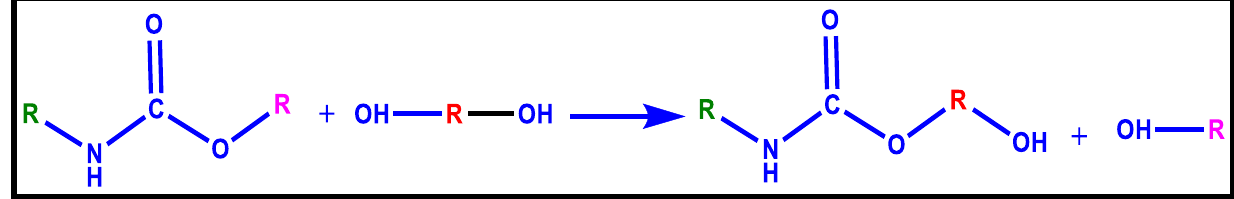
Figure 15. Glycolysis of Polyurethanes [118].